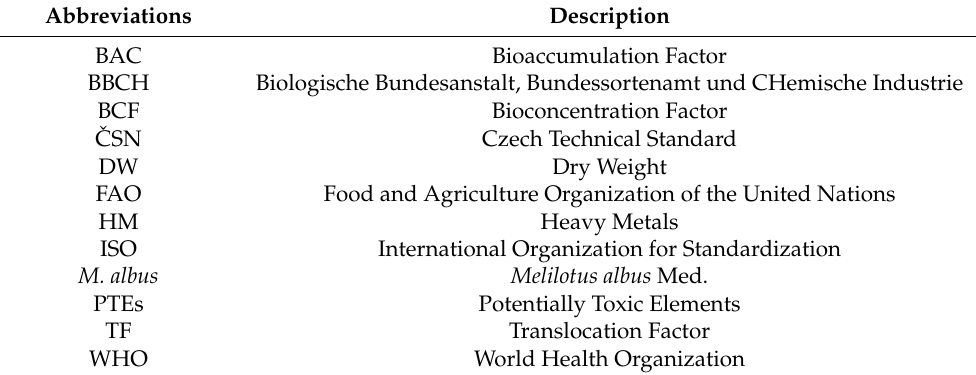
Table A1. List of abbreviations.